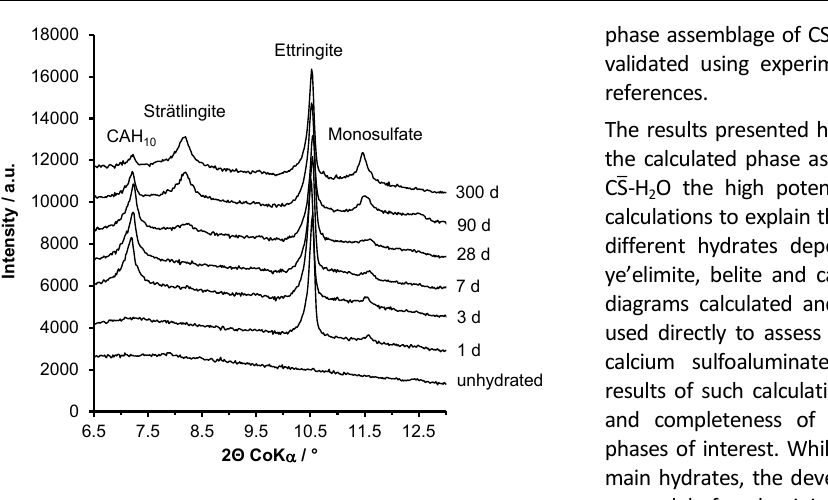
Figure 4 . X-ray diffraction patterns of the CSA clinker used in study [29] (unpublished data) depending on hydration time (w/c =